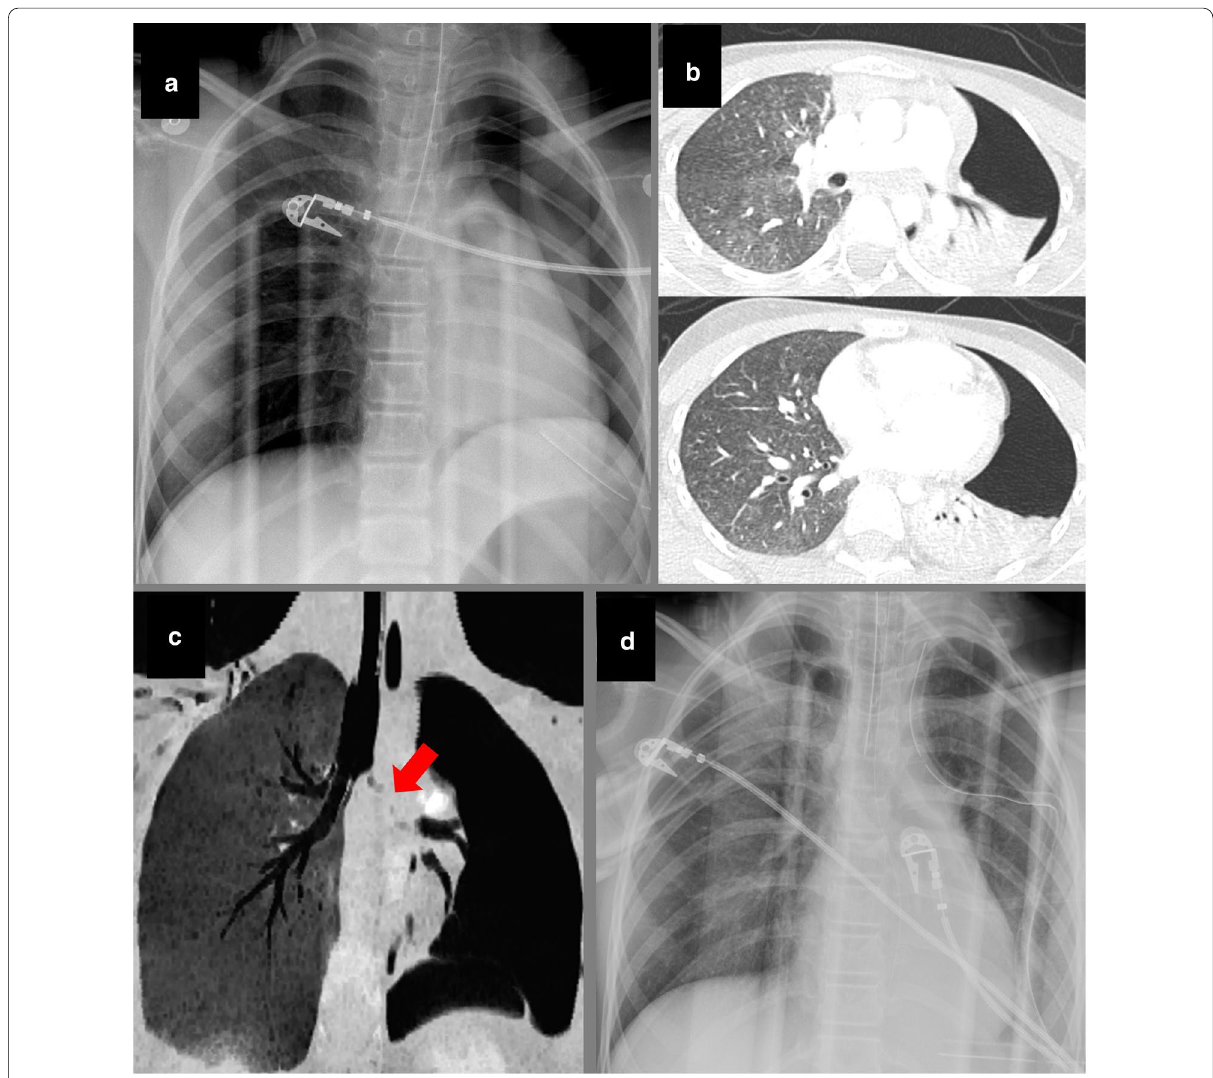
Fig. 4 Faulty reasoning (type 2) error with anchoring and confirmation bias. A 10-year-old female patient was admitted to the ER after MVA. She had signs of severe head trauma and was intubated in the ER due to altered mental status. Following intubation, the absence of left lung ventilation was noticed, and a chest tube was placed in the left lung. Left-sided pneumothorax and misplaced intubation cannula extending to the bronchus intermedius were seen on the control chest radiograph ( a ). After stabilizing the vital signs, thorax and abdomen CTs were performed in the second hour of admission to assess the severity of the traumatic injury. Thorax CT showed “collapsed left lung with pneumothorax” ( b , c ) and “discontinuity of left main bronchus” (red arrow, c ). The on-call radiologist evaluated those findings in favor of “bronchial rupture” and “fallen lung sign.” After making a preliminary report, the radiologist was called by a clinician, who informed him that patient’s intubation was traumatic and difficult, and asked him whether these findings could be secondary to “acute bronchial obstruction and subsequent collapse.” The radiologist rejected this possibility without thinking and stated that the findings he saw were compatible with bronchial rupture. Following the telephone call, the radiologist scanned the literature and read that bronchial rupture is usually seen with severe accompanying thoracic injuries and is associated with pneumomediastinum and pneumothorax. Although the radiologist knew that the patient did not have any other thoracic injury or pneumomediastinum, he sought exceptional cases that supported his pre-diagnosis, and he stuck with his first decision. The patient’s poor general condition did not allow surgical intervention or bronchoscopy. She was followed up with chest tube drainage and bronchial aspiration. On the second day after admission, portable chest radiography showed that the left lung ventilation was markedly normalized ( d ). When the findings were evaluated retrospectively, it was understood that bronchial rupture was unlikely, and the diagnosis was compatible with “acute lung collapse and pneumothorax ex vacuo secondary to the traumatic intubation.” Thus, the radiologist, under the influence of anchoring confirmation bias, had falsely attributed the findings he detected in favor of a false